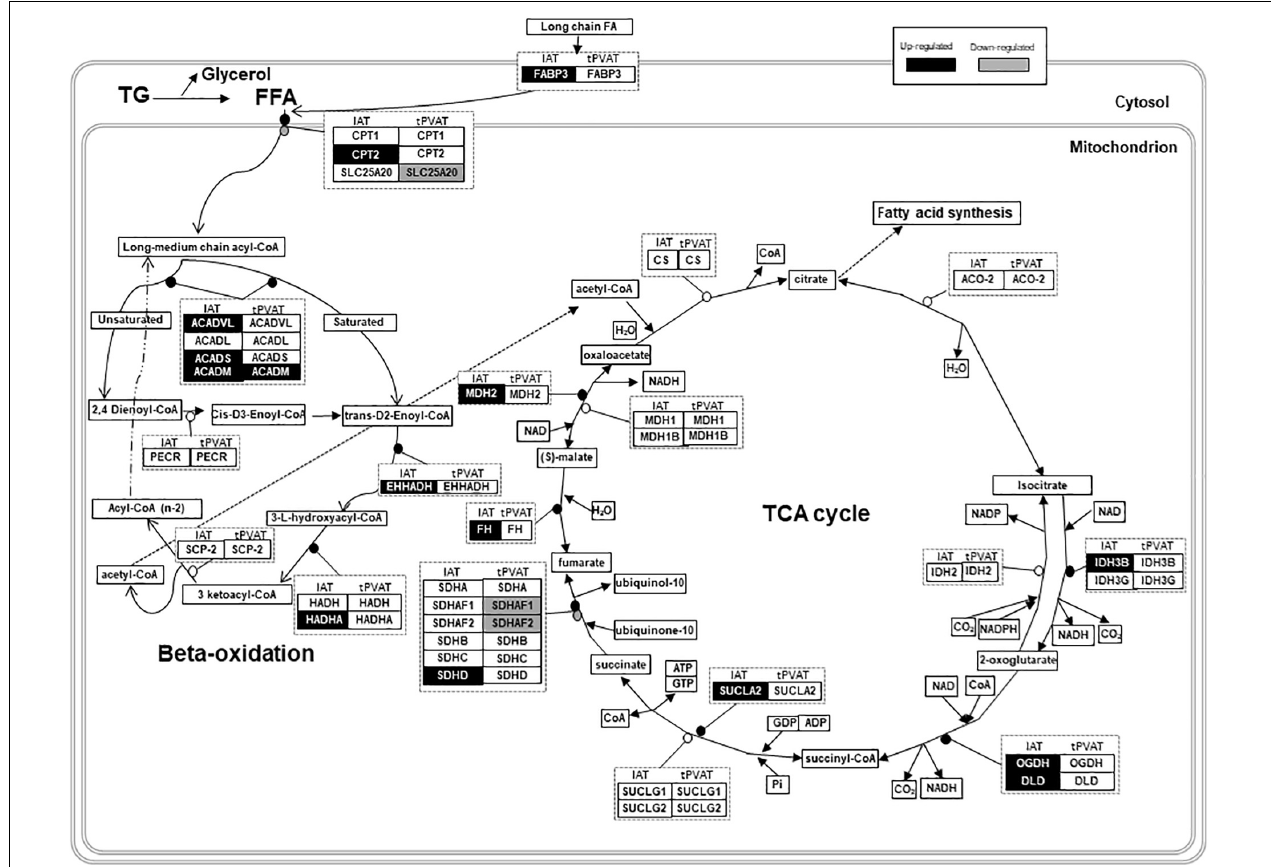
FIGURE 5 | Schematic overview of gene expression regulation of fatty acid oxidation and tricarboxylic acid (TCA) cycle in tPVAT and IAT. Up-regulated genes are marked in black and down-regulated are marked in gray (Student’s t -test, p -value < 0.05). Source: WikiPathways (adapted). According to the license terms of WikiPathways, users are free to use the pathway images in presentations, documents, websites and publications; as well as to use the pathway data in analyses, qualitative or quantitative, while citing or giving appropriate attribution (https://www.wikipathways.org/index.php/WikiPathways:License_Terms). ACADL, Acyl-CoA Dehydrogenase, Long Chain; ACADM, Acyl-CoA Dehydrogenase, C-4 To C-12 Straight Chain; ACADS, Acyl-CoA Dehydrogenase, C-2 To C-3 Short Chain; ACADVL, Acyl-CoA Dehydrogenase, Very Long Chain; ACO-2, Aconitase; CPT1, Carnitine Palmitoyltransferase 1; CPT2, Carnitine Palmitoyltransferase 2; CS, Citrate Synthase; DLD, Dihydrolipoamide Dehydrogenase; EHHADH, Enoyl-CoA Hydratase And 3-Hydroxyacyl CoA; FFA, Free Fatty Acids; FABP3, Fatty Acid Binding Protein 3; FH, Fumarate Hydratase; HADH, Hydroxyacyl-CoA Dehydrogenase; HADHA, Hydroxyacyl-CoA Dehydrogenase/3-Ketoacyl-CoA; IDH2, Isocitrate Dehydrogenase (NADP(+)) 2, Mitochondrial; IDH3B, Isocitrate Dehydrogenase 3 (NAD(+)) Beta; IDH3G, Isocitrate Dehydrogenase 3 (NAD(+)) Gamma; MDH1, Malate Dehydrogenase 1; MDH1B, Malate Dehydrogenase 1B; MDH2, Malate Dehydrogenase 2; NAD, Nicotinamide Adenine Dinucleotide; OGDH, Oxoglutarate Dehydrogenase; PECR, Peroxisomal Trans -2-Enoyl-CoA Reductase; SCP-2, Sterol Carrier Protein 2; SDHA, Succinate Dehydrogenase Complex Flavoprotein Subunit A; SDHAF1, Succinate Dehydrogenase Complex Assembly Factor 1; SDHAF2, Succinate Dehydrogenase Complex Assembly Factor 2; SDHB, Succinate Dehydrogenase Complex Iron Sulfur Subunit B; SDHC, Succinate Dehydrogenase Complex Subunit C; SDHD, Succinate Dehydrogenase Complex Subunit D; SLC25A20, Solute Carrier Family 25 Member 20; SUCLA2, Succinate-CoA Ligase ADP-Forming Beta Subunit; SUCLG1, Succinate-CoA Ligase Alpha Subunit; SUCLG2, Succinate-CoA Ligase GDP-Forming Beta Subunit; TG,